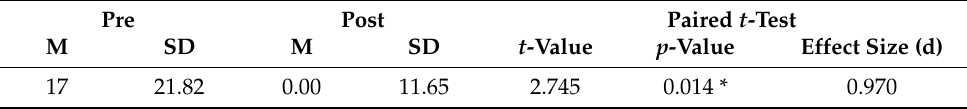
Table 4. Statistical results for changes in TMD scores pre and post virtual forest